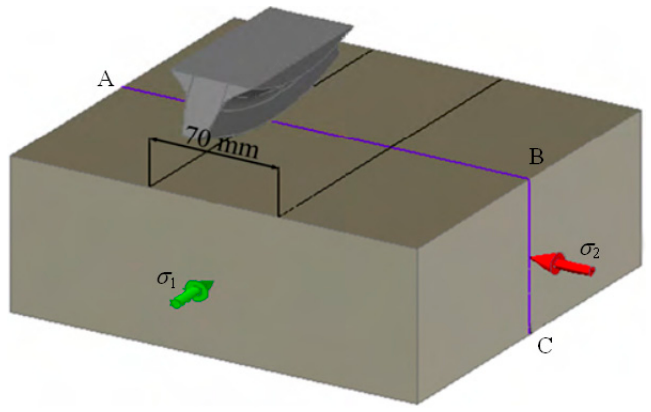
Figure 4. Schematic representation of penetration test for TBM disc cutters. Table 1. Values of confining pressure for three different groups .